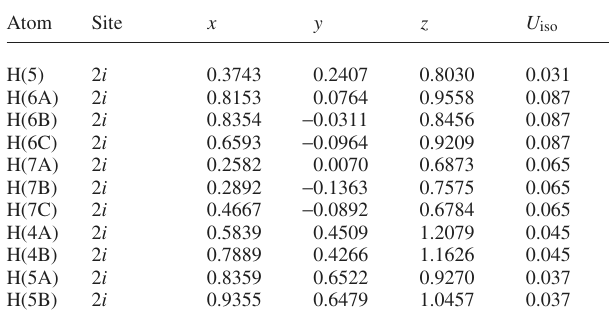
Table 2. Atomic coordinates and displacement parameters (in Å 2 )